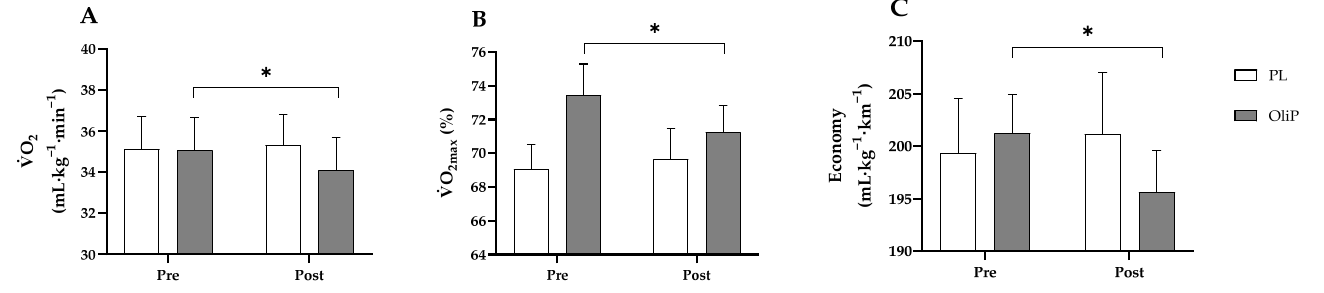
Figure 3. Summary respiratory and economy differences at lactate threshold (LT1) intensity pre and post 16 consecutive days consumption of either OliP or PL for ( A ) and ( C ) running economy. * denotes significance between time points in the OliP group ( p <